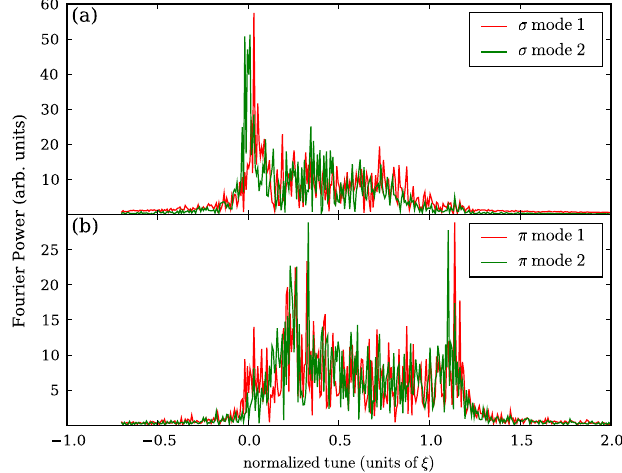
FIG. 13. (Color) Mode tune spectrum for a two-on-two bunch run at 2 : 2 (cid:2) 10 11 particles/bunch ( (cid:9) ¼ 0 : 01 ). Figure (a) shows the two modes that are most like (cid:6) modes. (cid:6) mode 1 is 0 : 53 y 1 þ 0 : 53 y